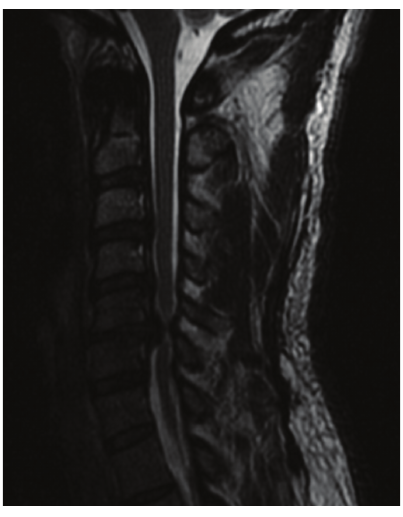
F 2: Preoperative MRI sagittal showing large area of high signal intensity centered behind the massive C5-6 herniated disc.